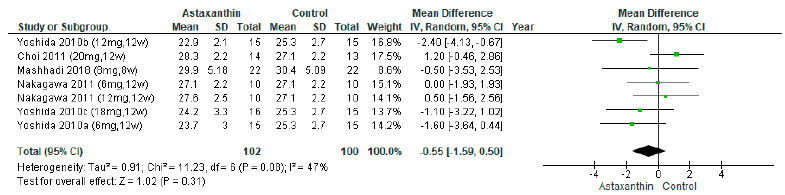
Figure 2. Forest plot of effect of astaxanthin on body mass index [26–28,30]. Bold means total data.